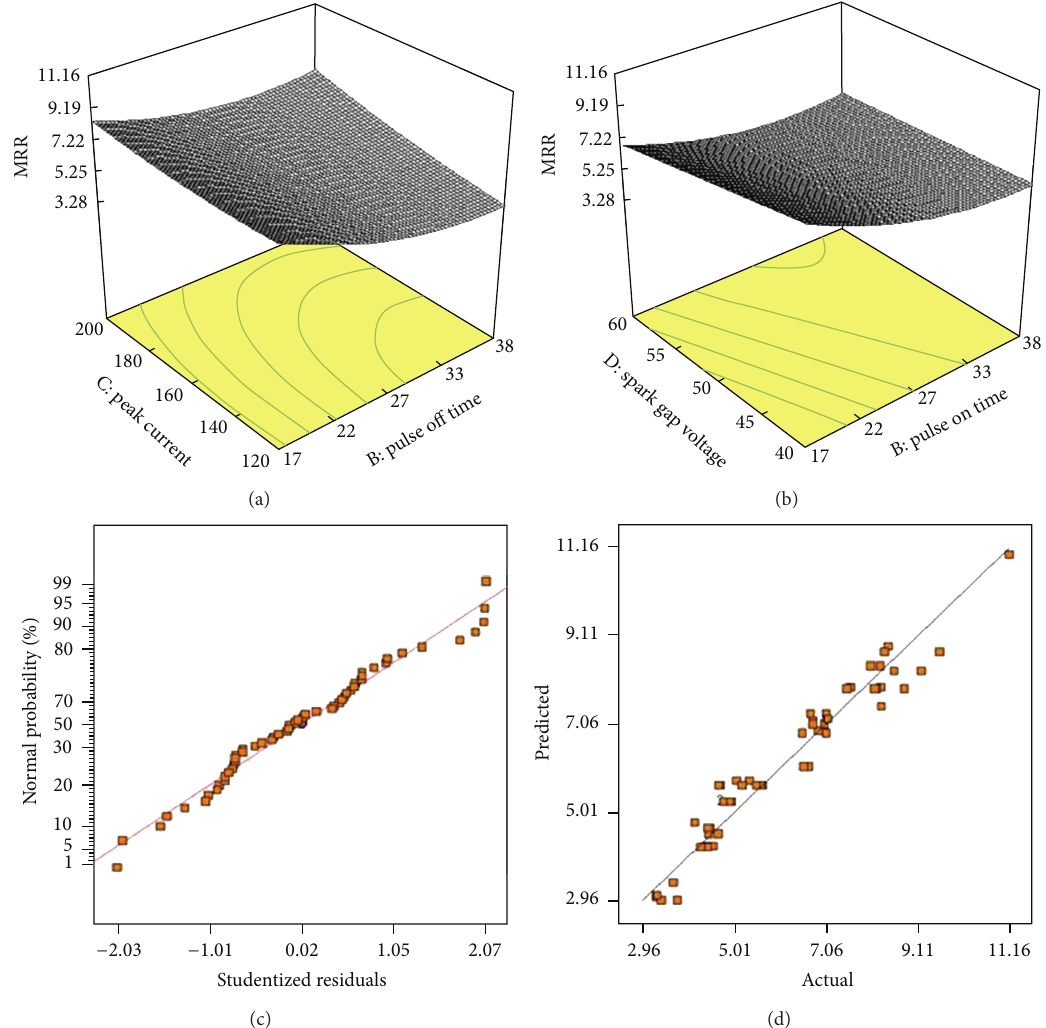
Figure 2: Response surface plot for MRR: (a) interaction plot between pulse off time and peak current, (b) interaction plot between pulse off time and spark gap voltage, (c) normal probability plot residuals, (d) actual versus predicted values. 𝐵 2 , 𝐶 2 , 𝐸 2 , 𝐹 2 , and 𝐴𝐷 were significant model terms. The lack of fit 𝐹 value of 0.1719 implies that it is not significant compared to pure error. The “Pred. 𝑅 -squared” of 0.8191 is in reasonable agreement with the “Adj. 𝑅 -squared” of